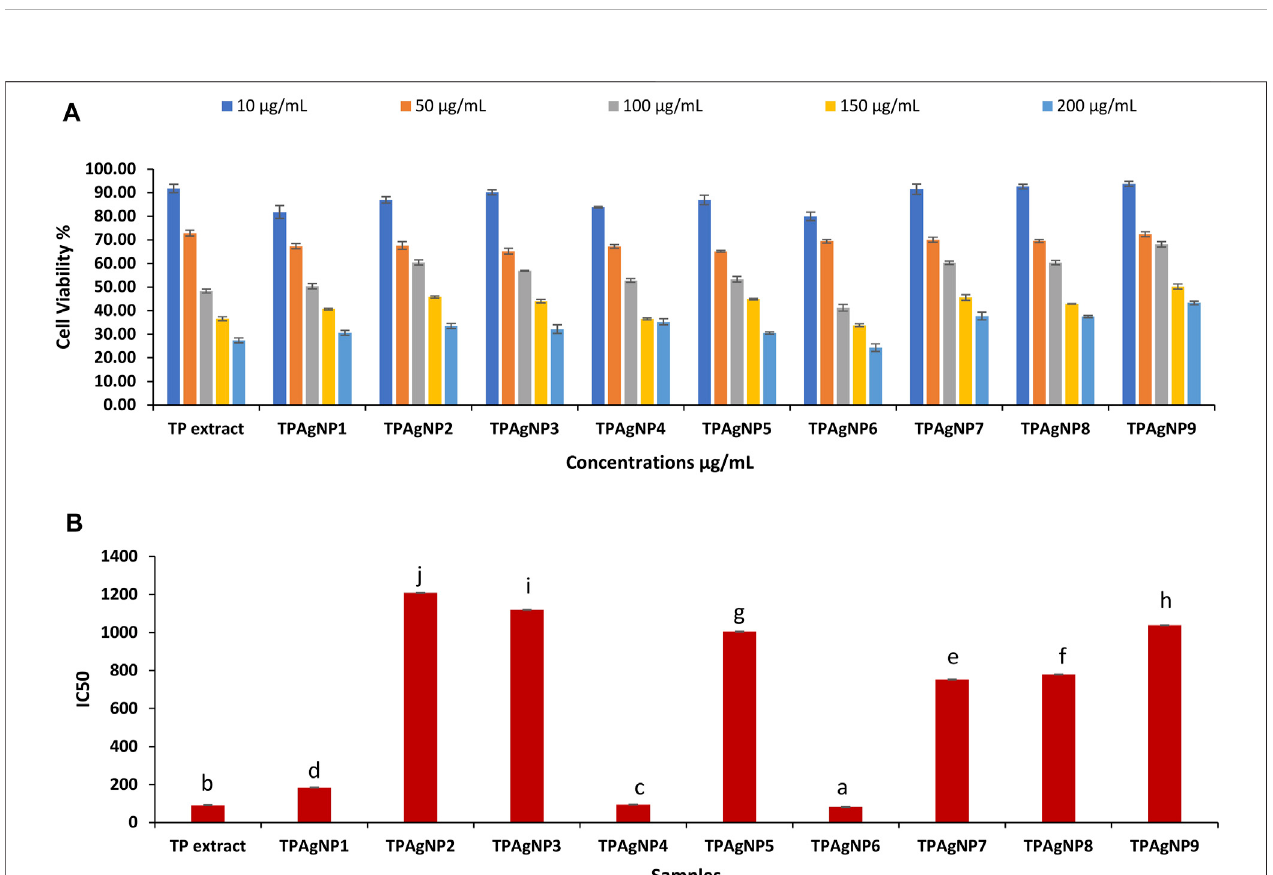
Frontiers in Bioengineering and Biotechnology |